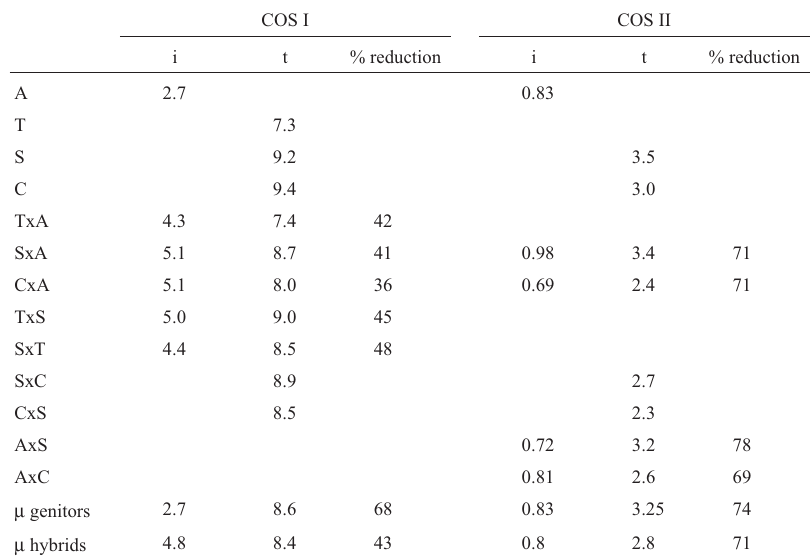
Table 1 - Mean scion diameter (cm) for Valencia orange grafted onto Azeda (A), Trifoliata (T), Sunki (S), Cravo (C) and their hybrids segregating for tolerant(t)andintolerant(i)hybridstotristeza,andthecorrespondingpercentagereductioninthisparameterinintoleranthybridsinCOSIandIIplotsin 1998. The COS I and COS II plots contained 633 and 2823 plants, respectively. µ = average. COS I